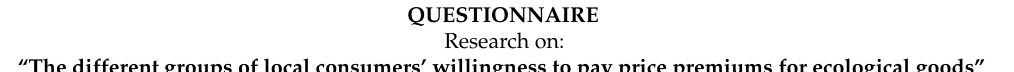
Table 1. Questionnaire: The different groups of local consumers’ willingness to pay price premiums for ecological